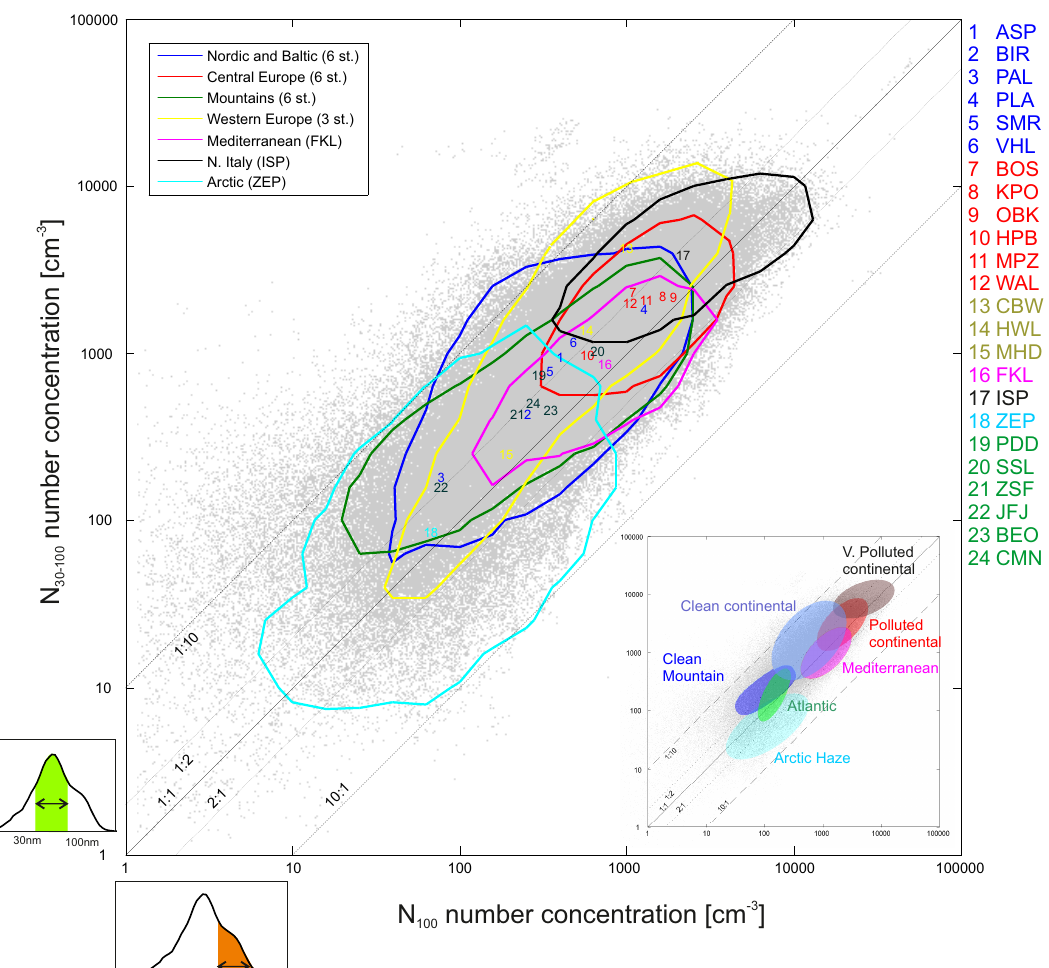
Fig. 13. Scatter plot of particle concentration between 30 and 100nm as a function of particle concentrations above 100nm (grey points). The station groupings are shown with different colours, with the contours showing the areas with greatest density of each station grouping. The contours are drawn to include 83% of the each group data points. The colour coded numbers in the plot indicate the coordinates of the geometric means of both concentrations for each station. The insert shows an interpretation of the approximate aerosol types in the same axes. See text for